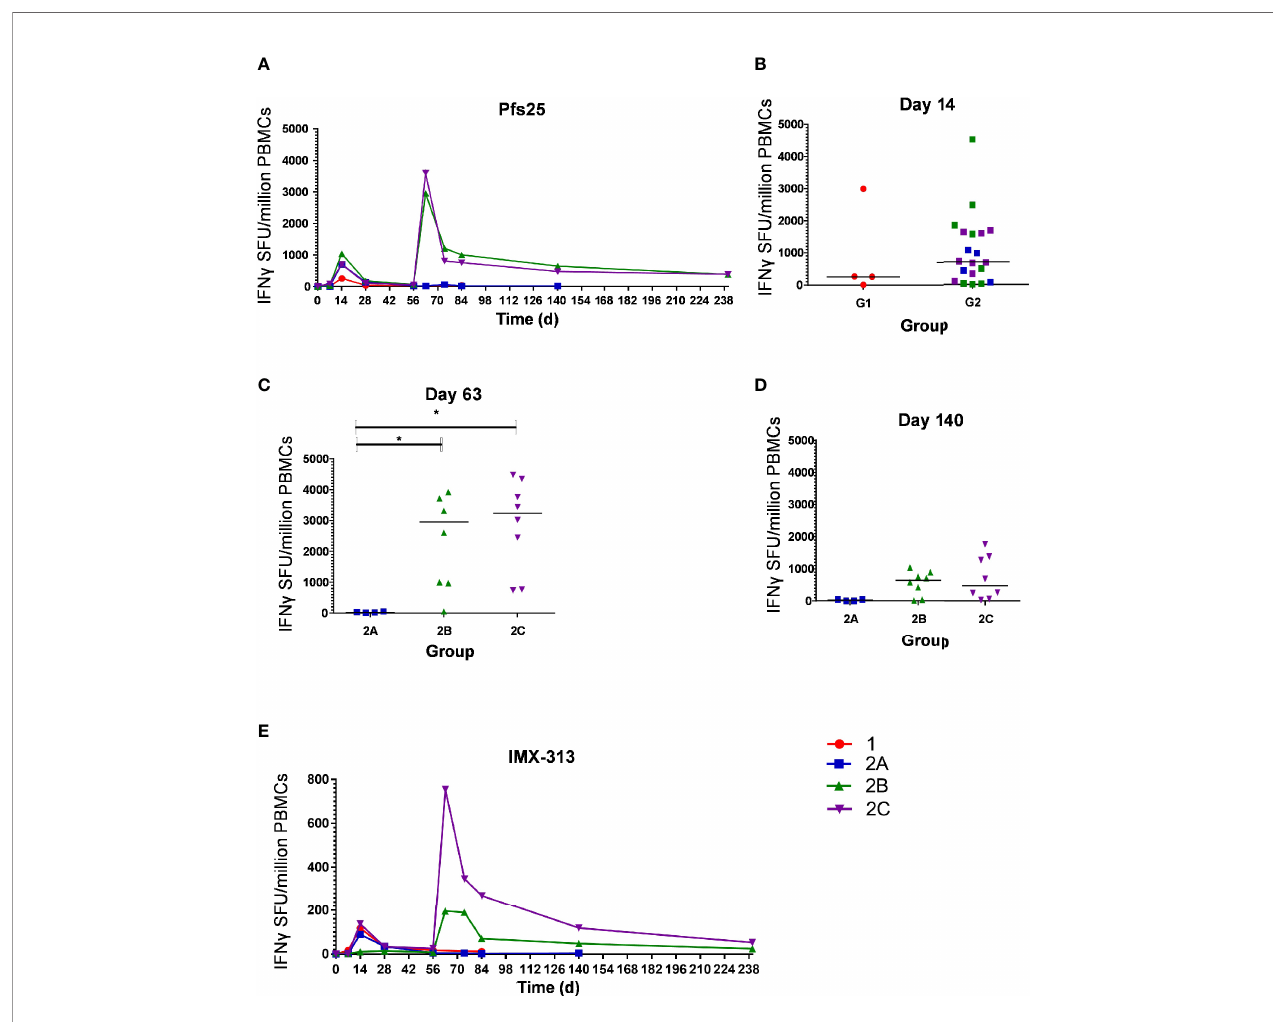
FIGURE 3 | Ex-vivo IFN- g T cell response against Pfs25 and IMX313. (A) Median ex vivo IFN- g ELISPOT responses in PBMCs to the Pfs25 insert (summed response across all the individual peptide pools) are shown for all groups. Individual responses are shown in Supplementary Figure 1 . Median and individual responses are shown at (B) day 14, (C) day 63, and (D) day 140. Symbols are coded according to group. *P < 0.05. Responses between Groups 1 (n = 4) and 2 (n = 20) at day 14, and between Groups 2B (n = 7) and 2C (n = 8) at day 140 were assessed by Mann-Whitney test (B , D) ; responses between groups 2A (n = 4), 2B (n = 7), and 2C (n = 8) at day 63 were assessed by Kruskal-Wallis test with Dunn ’ s multiple comparison test (C) . (E) Median ex vivo IFN- g ELISPOT responses in PBMCs to the IMX313 insert (summed response across a single peptide pool) shown for all groups. SFU, spot-forming